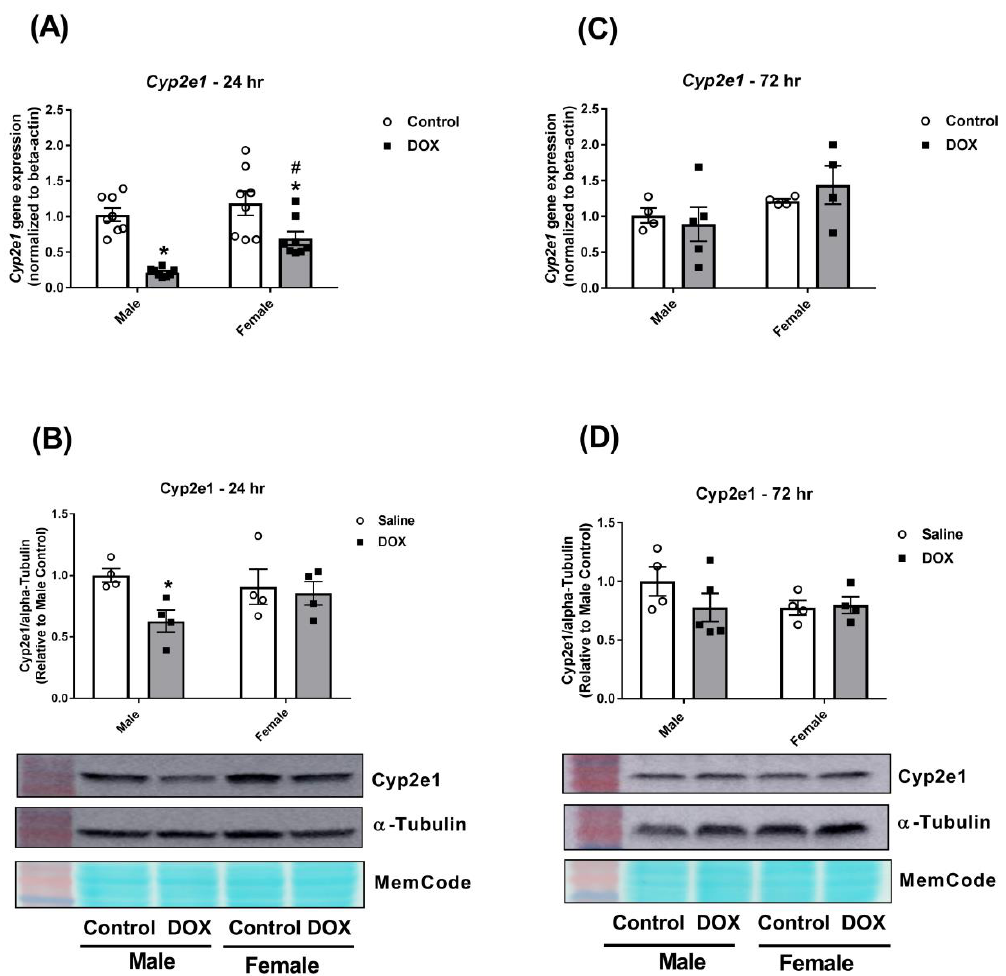
Figure 5. E ff ect of DOX treatment on the expression of Cyp2e1 in the liver. Livers were collected from male or female C57Bl / 6 mice 24 or 72 h following the administration of a single intraperitoneal injection of 20 mg / kg DOX or saline, and total proteins and RNA were isolated. ( A ) Gene expression of Cyp2e1 was determined by real-time PCR ( n = 8 per group), and ( B ) protein levels of Cyp2e1 were determined by western blotting ( n = 4 per group) in samples collected 24 h following DOX treatment. ( C ) Gene expression of Cyp2e1 ( n = 4–5 per group) and ( D ) protein levels of Cyp2e1 ( n = 4–5 per group) were determined in samples collected 72 h following DOX treatment. PCR results were normalized to beta-actin , and protein expression was normalized to alpha-tubulin. Results of all groups are expressed relative to the male control. Data are presented as the mean ± SEM. * p < 0.05, compared to control mice of the same sex; # p < 0.05, compared to male DOX-treated mice.